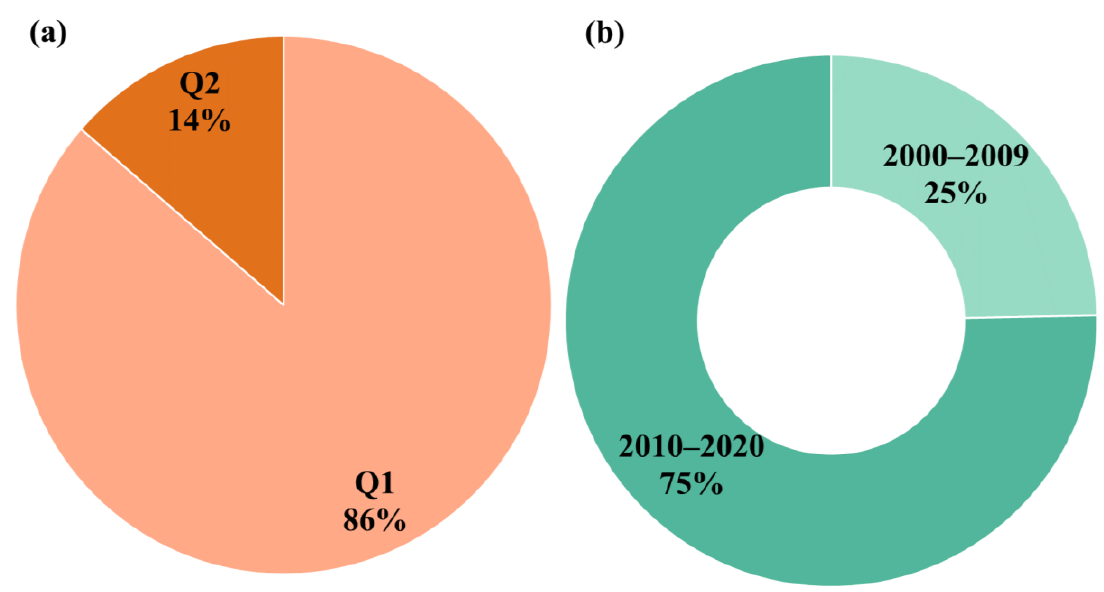
Figure 4. Statistics of studied articles: distribution of articles according to Q-index ( a ) and publication year ( b ).